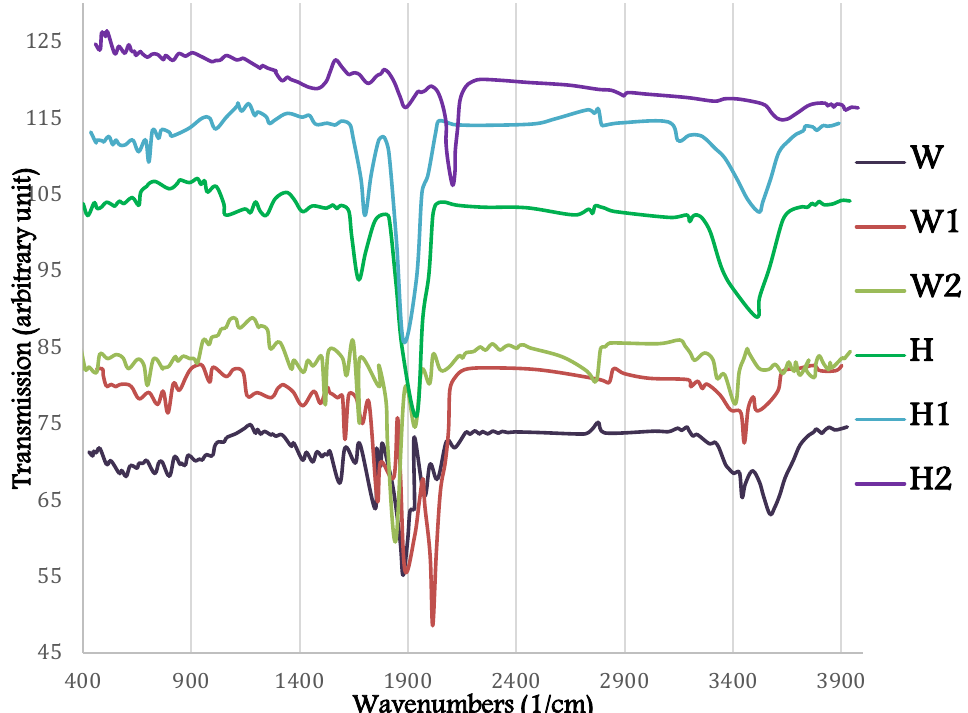
Figure 0ː FTIR spectra of the pure PANI with H